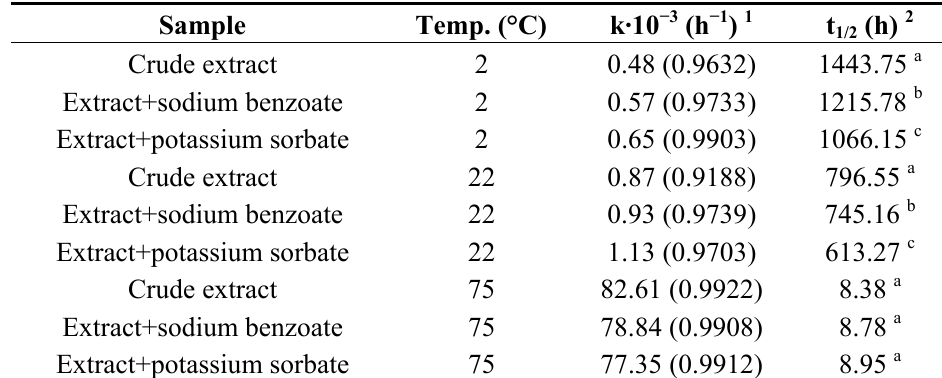
Table 1. Kinetic parameters of degradation of anthocyanins from Cornelian cherriesextracts in different